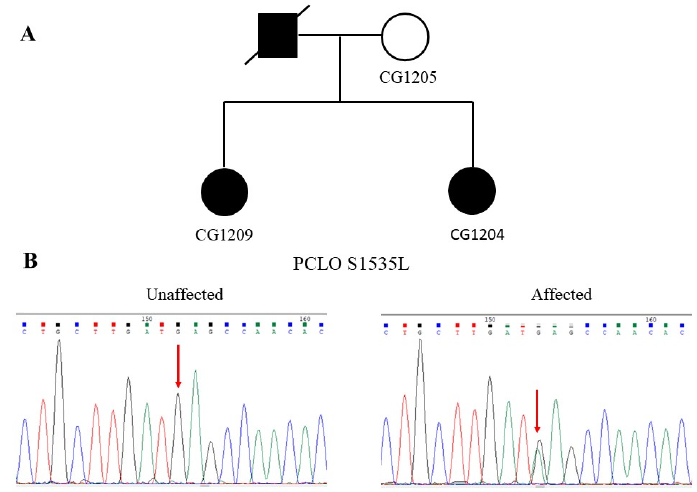
Figure 2. A family of bipolar disorder with the S1535L mutation of the PCLO gene. ( A ) The pedigree shows the dominant inheritance of bipolar disorder in this family. ( B ) Chromatograms show the wild-type G homozygote at the nucleotide position 82585665 of the unaffected mother’s PCLO gene. Simultaneously, both of the affected sisters carried the same G-to-A heterozygous mutation of the PCLO gene.